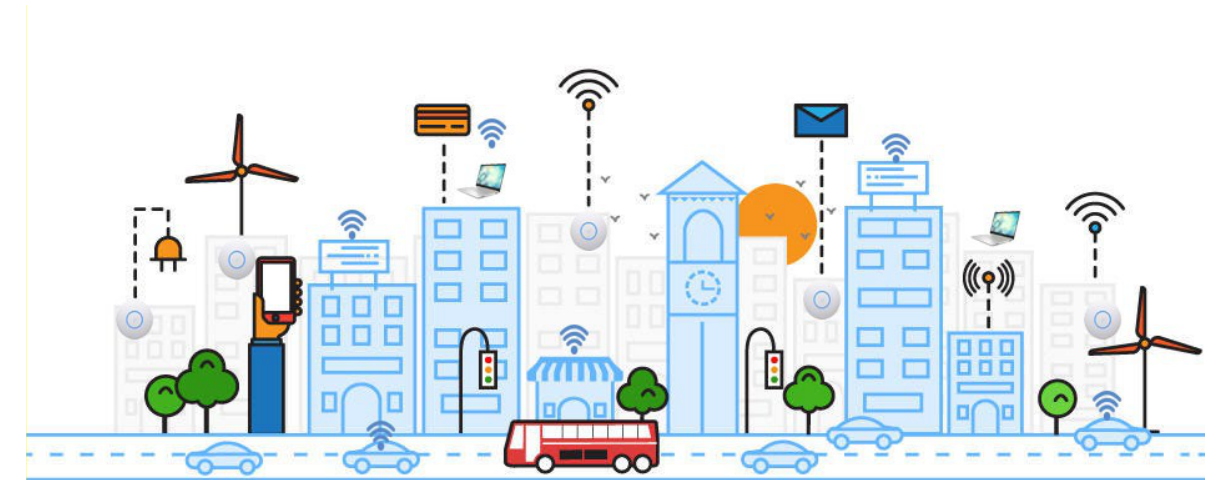
Figure 1. An illustration of MANET applications in smart cities